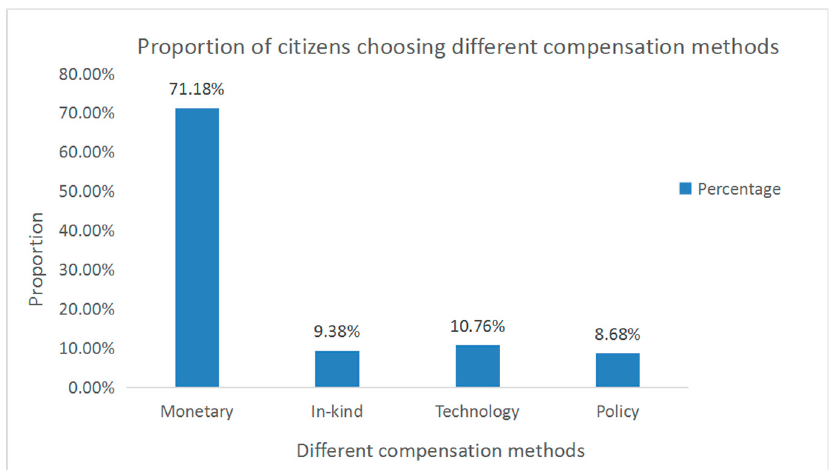
Figure 1. Citizens’ preferences for different farmland eco-compensation methods. Developed based on questionnaire surveys.